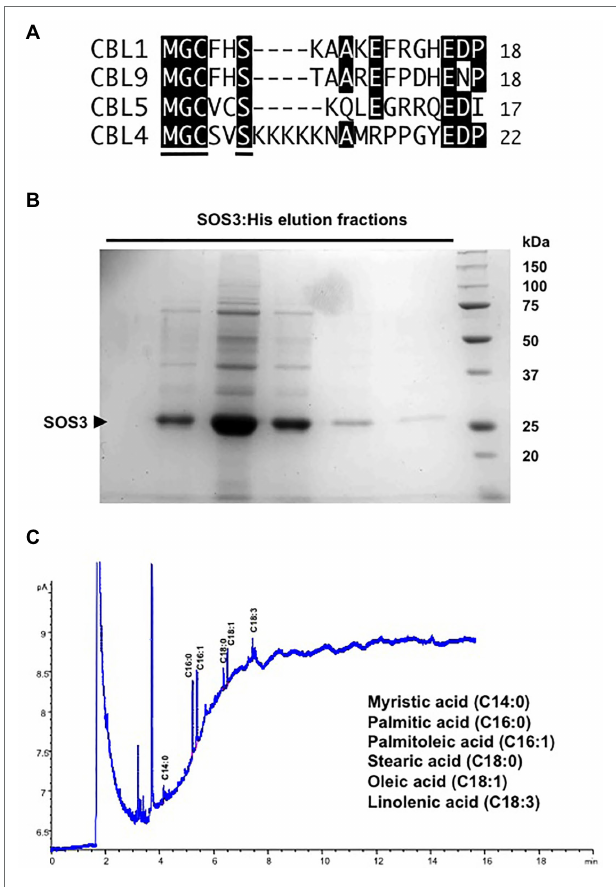
FIGURE 1 | Fatty acid acylations of SOS3. (A) Alignment of the N-terminal sequences of CBL1, CBL4/SOS3, CLB5, and CBL9 that undergo N-myristoylation and S-acylation in Arabidopsis . The consensus motif for dual acylation (MGCxxS) is underlined in the CBL4/SOS3 sequence. (B) His- tagged SOS3 protein expressed in yeast and purified by Ni-NTA affinity chromatography. Shown are the elution fractions with 250 mM imidazole resolved by SDS-PAGE and stained with Coomassie. The arrowhead indicates the SOS3 band. (C) Profile of fatty acids attached to purified SOS3 protein. Peaks in the GC chromatogram corresponding to myristic (C14:0), palmitic (C16:0), palmitoleic (C16:1), stearic (C18:0), oleic (C18:1), and linolenic (C18:3) acids are shown. Fatty acids were identified by comparison with known